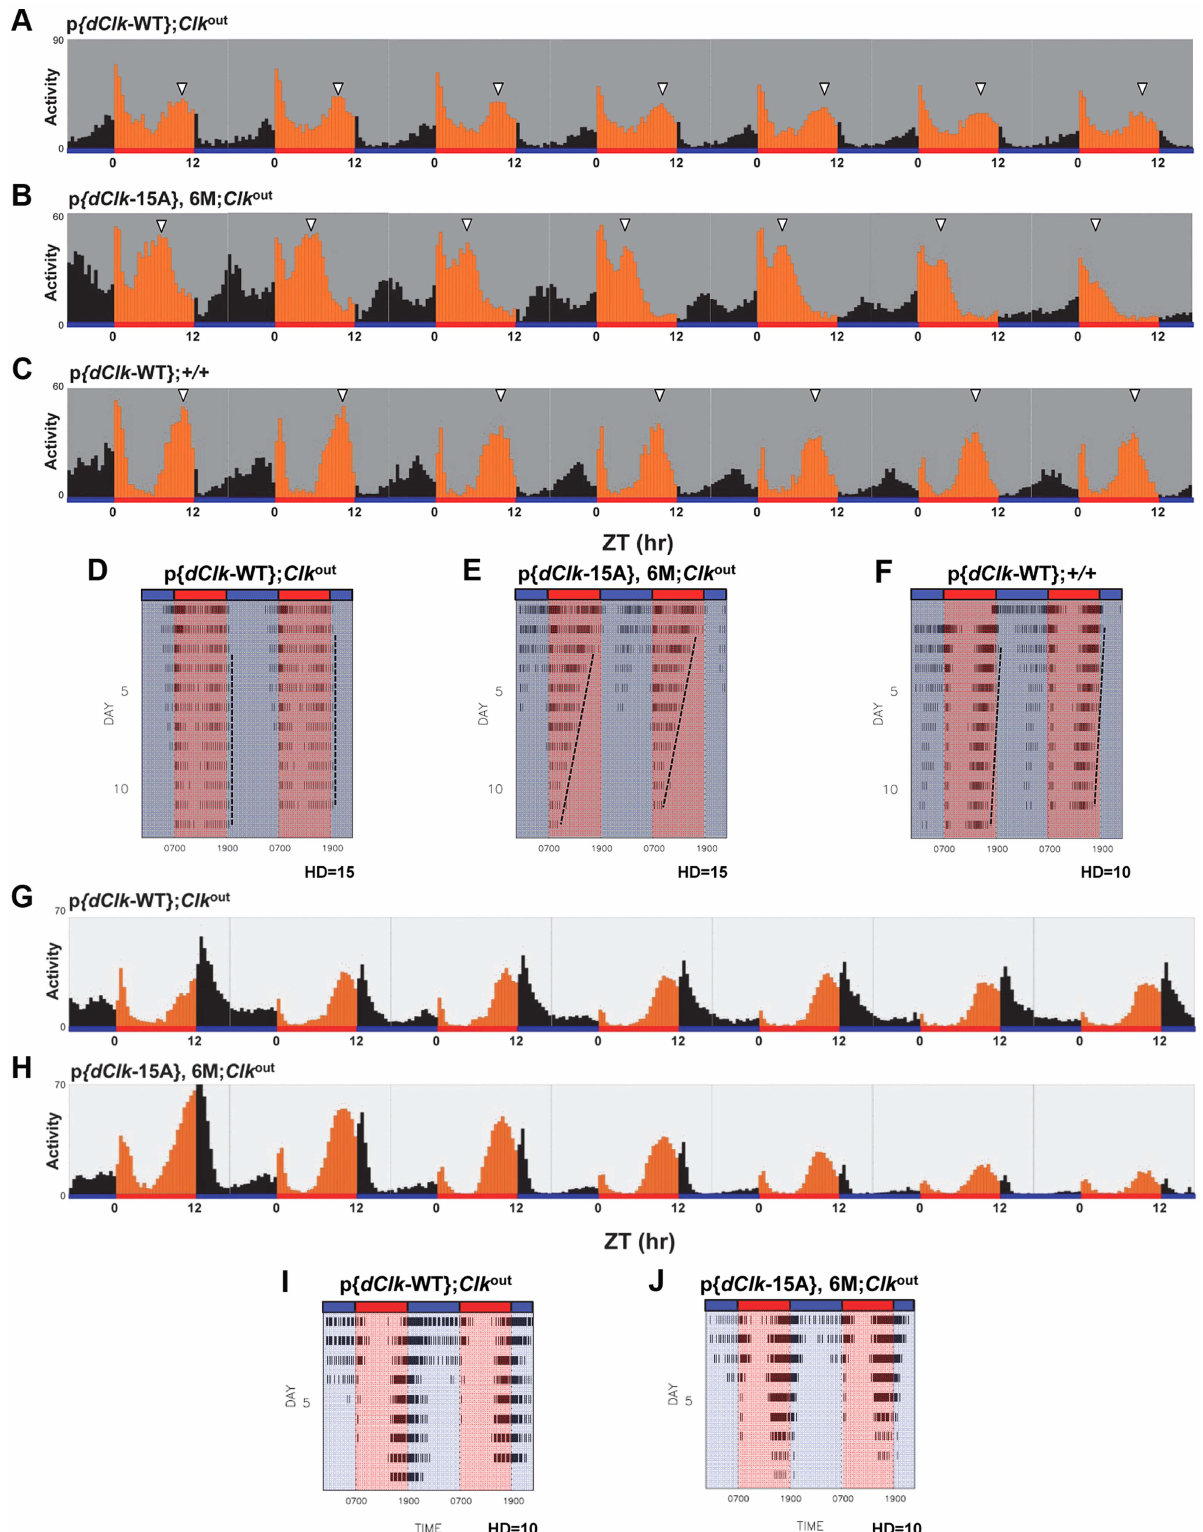
Figure 5. Impaired behavioral entrainment of p{ dClk -15A}; Clk out flies in daily temperature cycles. Adult male files of the indicated genotype were entrained in 12 h:12 h temperature cycles of 24 u C:29 u C in the absence (A–F) or presence (G–J) of constant light. (A–C, G, H) Each panel represents the daily average activity beginning on the third day of TC followed by 7 consecutive days. Orange vertical bars represent locomotor activities during the thermo phase and black vertical bars represent locomotor activities during the cryo phase. Red and blue horizontal bars indicate thermo- and cryo-phases, respectively. (D–F, I, J) Red and blue shades indicate thermo-and cryo-phases, respectively. The vertical black bars on each